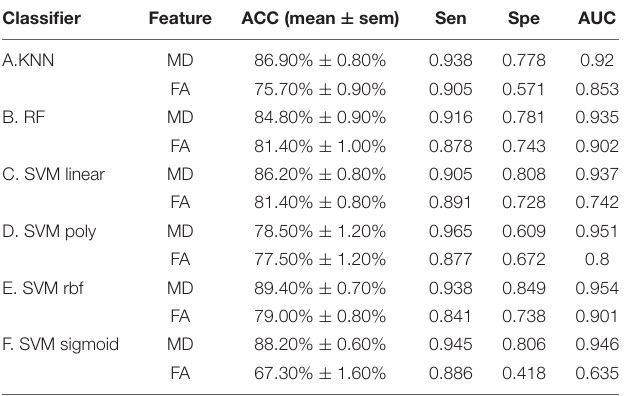
TABLE 3 | Classification performance of MD and FA feature sets.